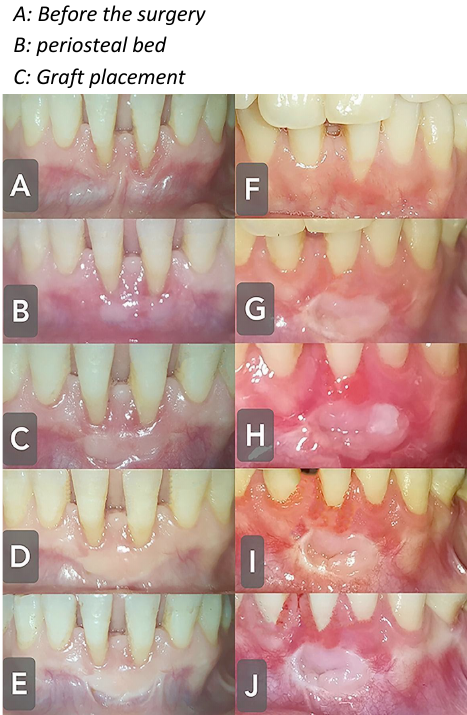
Figure 3. Free gingival graft surgical procedure